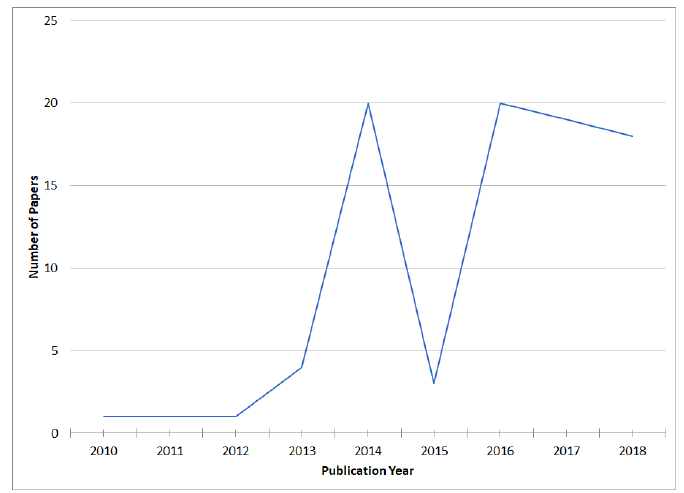
Figure 4. Research paper